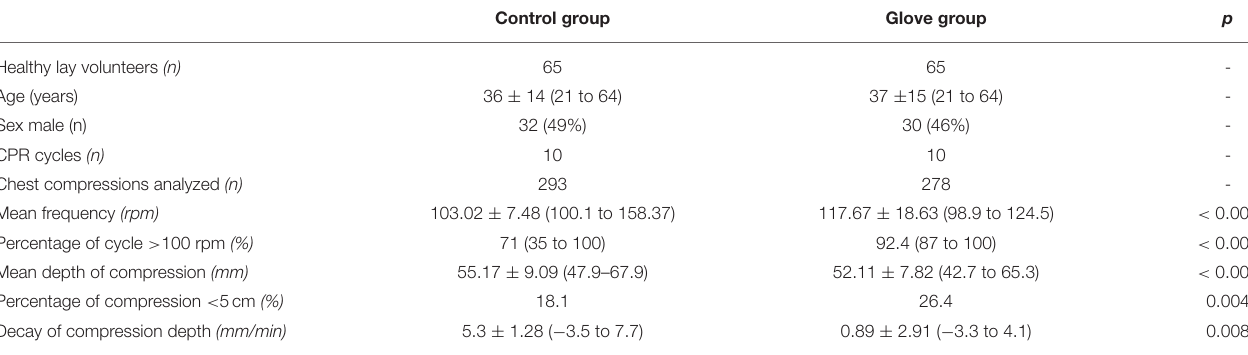
TABLE 1 | Patients’ characteristics and chest compression data.